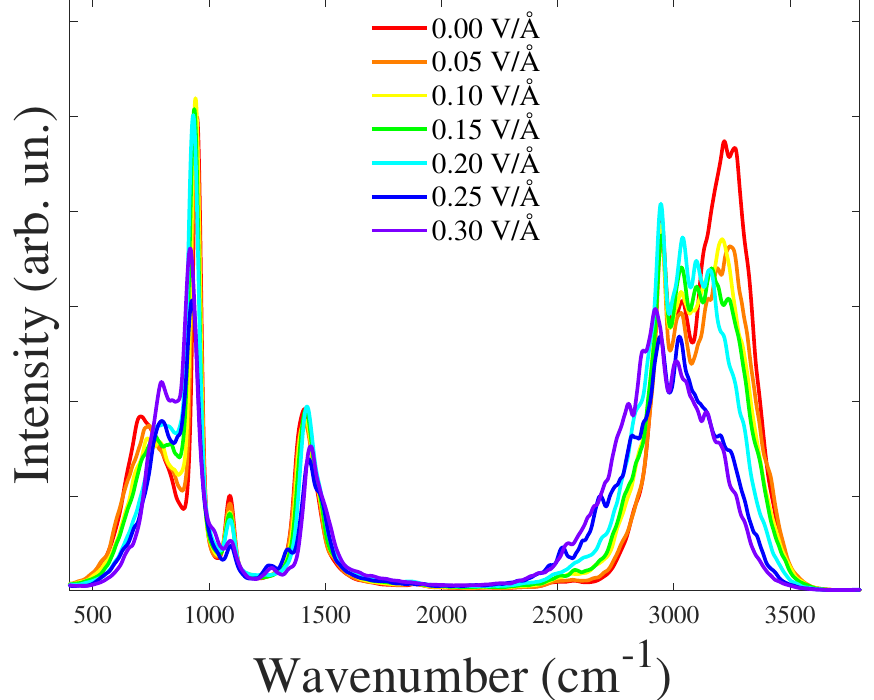
Figure 2. IR absorption spectra of bulk liquid methanol determined in absence (red line) and under different field intensities (colored from orange to violet) as detailed in the legend at 300